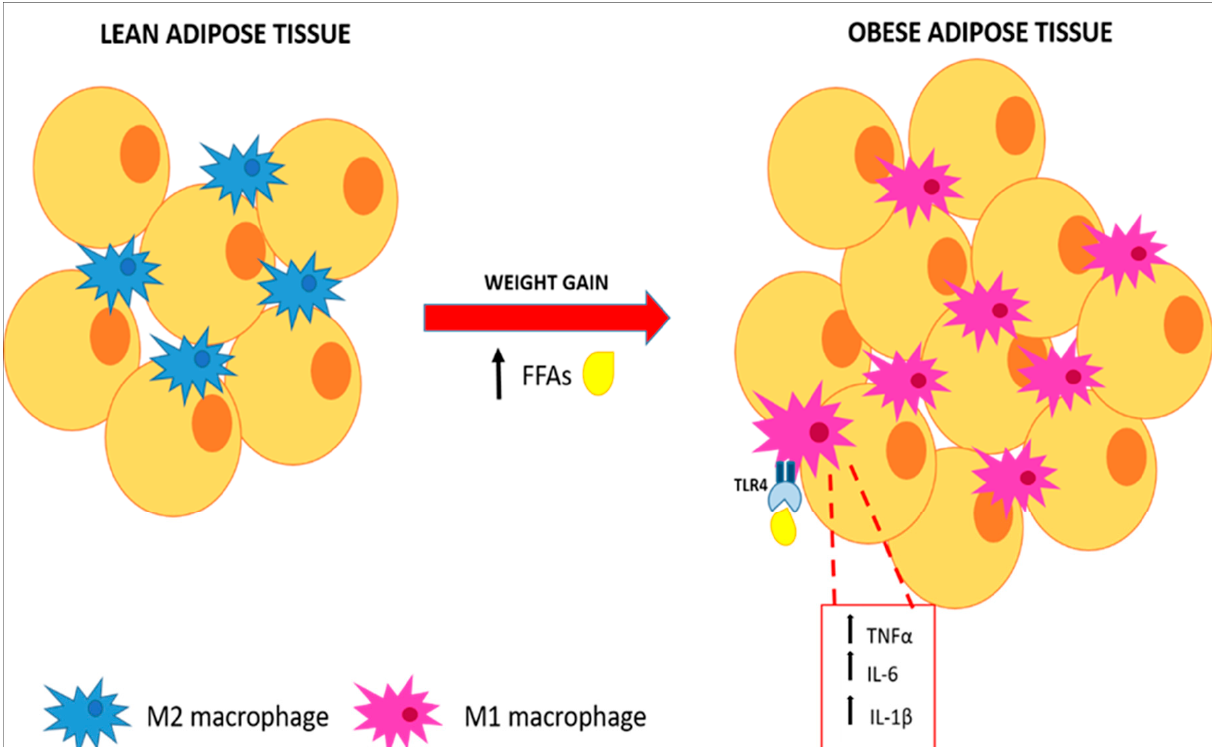
Figure 2. Macrophages polarization and pro-inflammatory cytokines expression. FAAs released by hypertrophic adipose tissue stimulate polarization of M2 macrophages through activation of the TLR4 pathway resulting in pro-inflammatory cytokines secretion.